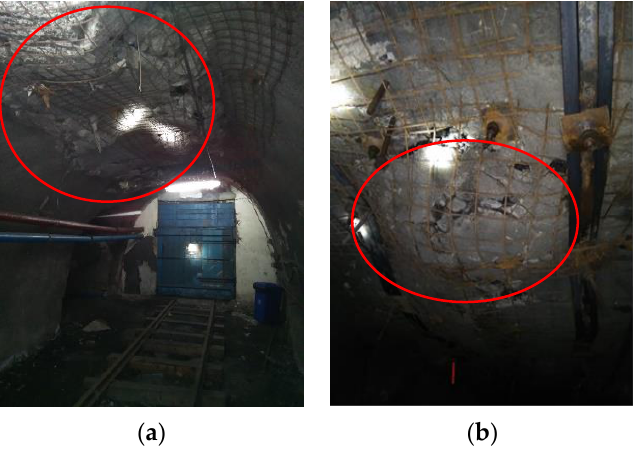
Figure 2. Damage of roadway. ( a ) The anchor support failure. ( b ) Sagging roof.